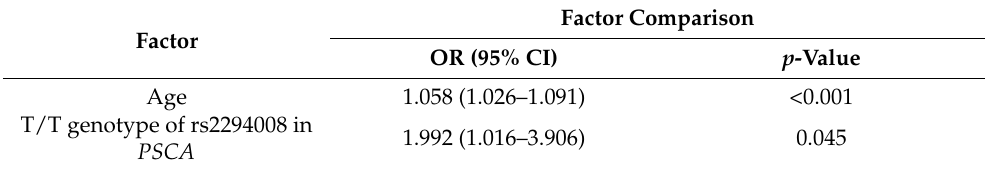
Table 5. Contribution of gene–environment interaction to GMA with regard to rs2294008 in PSCA